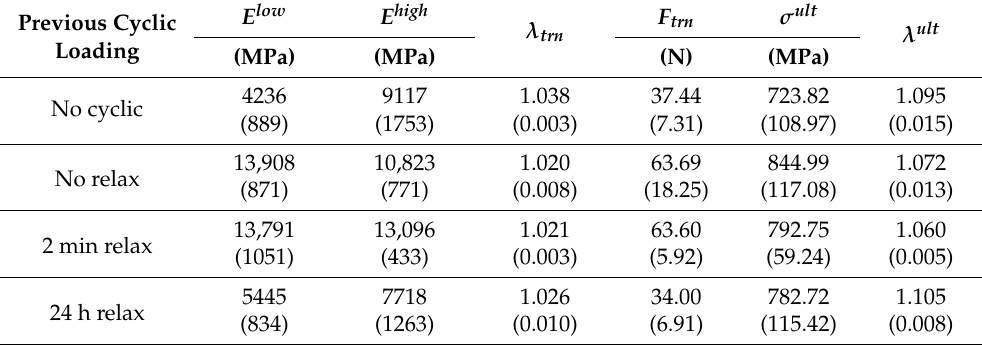
Table 4. Parameters of the bilinear model fit from the data of the load-to-failure tests performed at 1 mm/s without previous cyclic loading; immediately after 10 loading cycles at 1–50 N; after a relaxation period of 2 min following cyclic loading; and after a relaxation period of 24 h following cyclic loading. Values are given as the mean